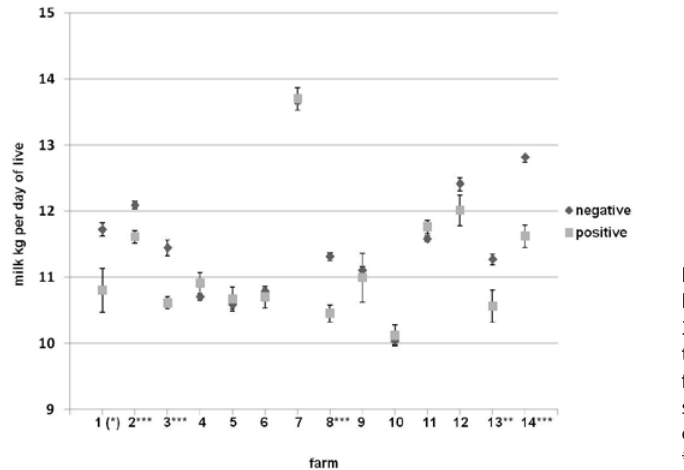
Figure 3 LS means for the average 305-day milk yield in kg for the interaction between farm and paratuberculosis status tested by faecal culture (* P≤ 0.05, ** P≤ 0.01, *** P≤ 0.001)